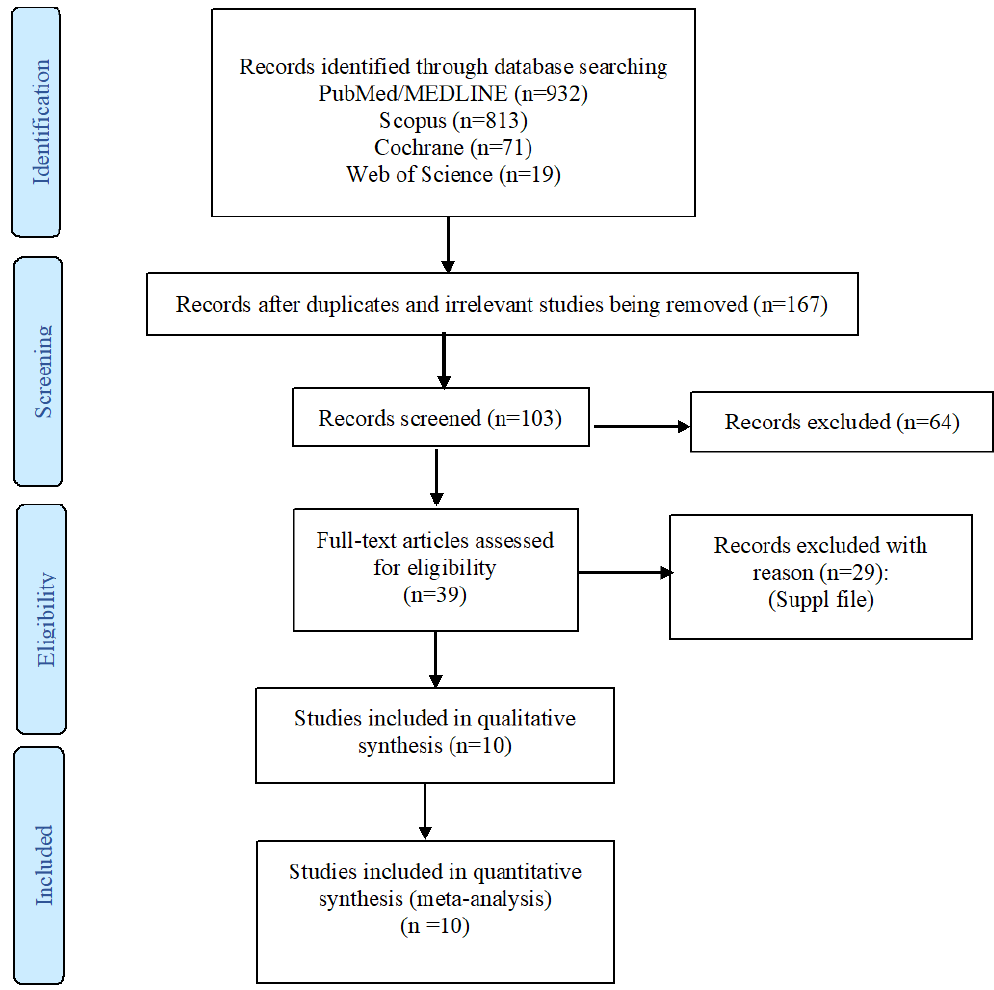
Figure 1. Flow chart of included studies.